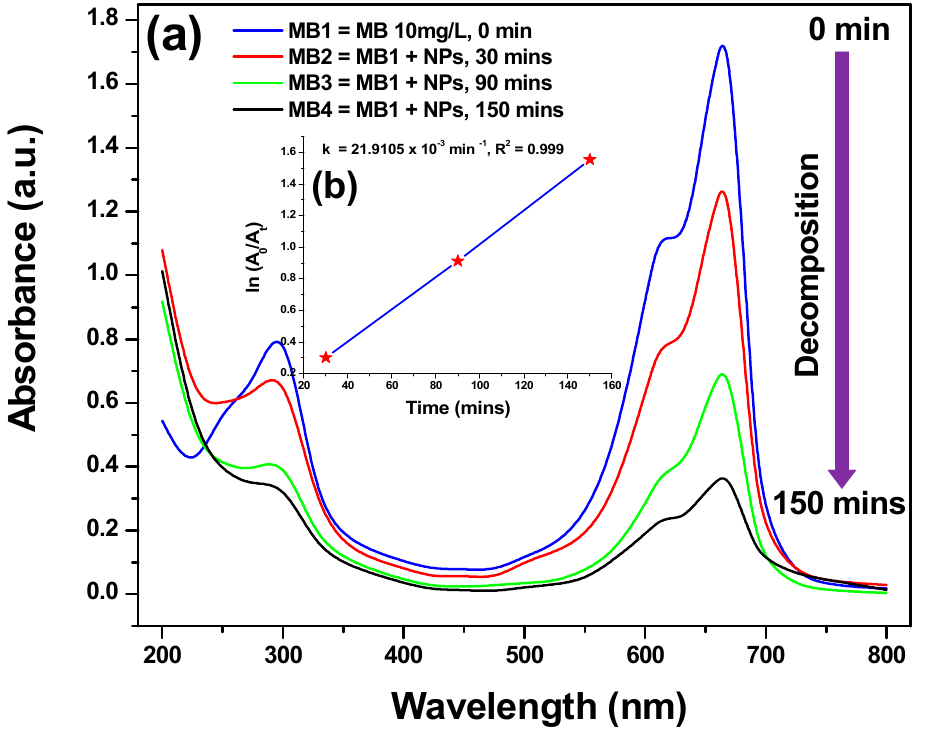
Figure 7. ( a ) Photocatalytic degradation pattern and ( b ) ln (A 0 / A t ) vs. time kinetic plot of MB using Cu 2 O nanoparticles as photocatalyst.